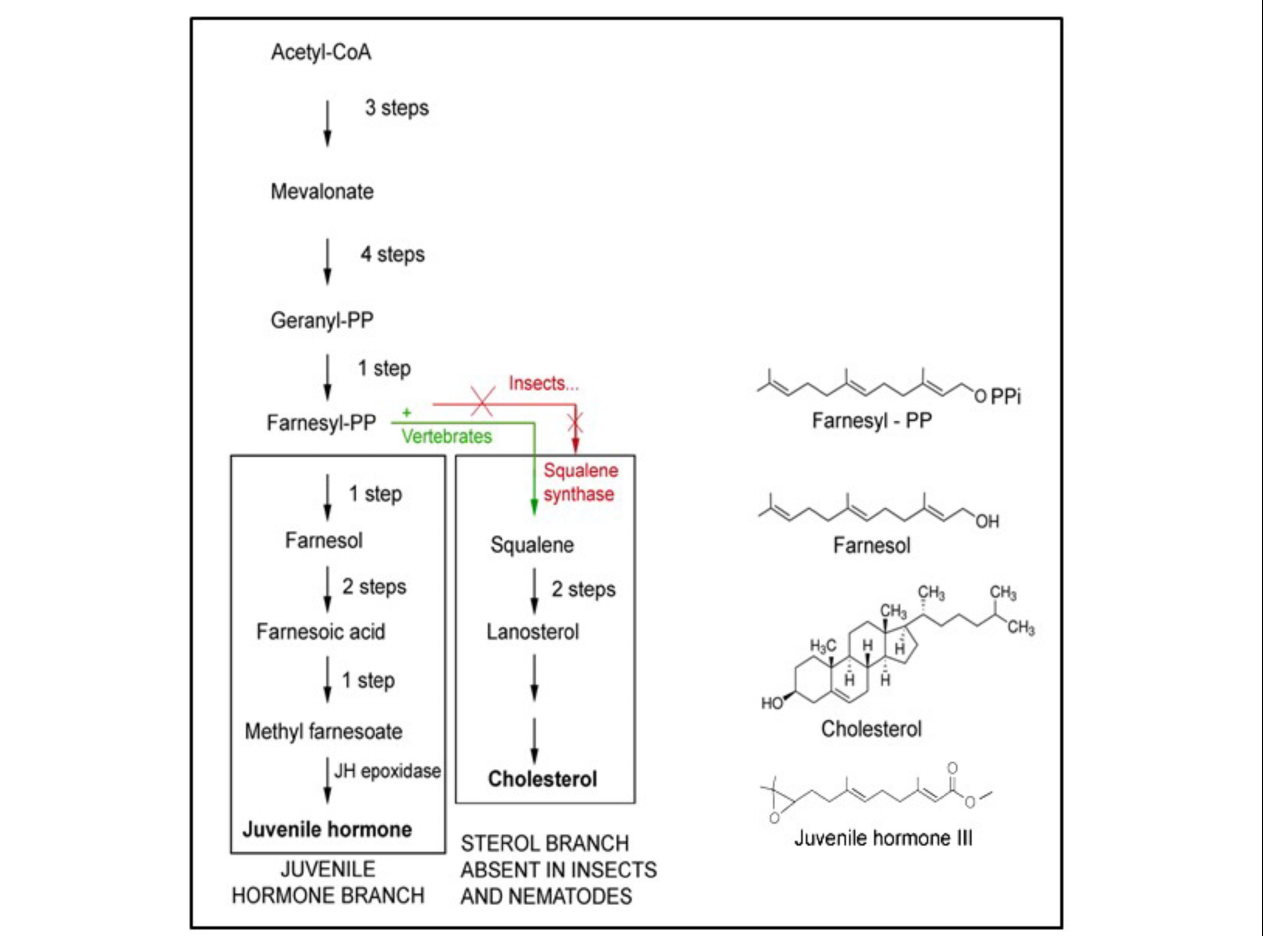
FIGURE 5 | The mevalonate biosynthetic pathway. It operates in all eukaryotes, thus mammals and humans inclusive, but with some “branch-specific “variability that is mainly linked to the presence or absence of the gene coding for the enzyme squalene synthase that is needed for the synthesis of squalene. This is the precursor of cholesterol, with its many functions, e.g., in the synthesis of sterols and “vertebrate-type steroid hormones”. Insects, nematodes and some other species cannot synthesize squalene. Hence, cholesterol is a vitamin for them. They 1215 1216 convert farnesol into esters ( Figure 2 ) whose juvenile hormone activity (in bioassays) is much 1217 higher than the mild one of farnesol itself. Adapted from De Loof et al., 2014, 2015a). Copyright permission not